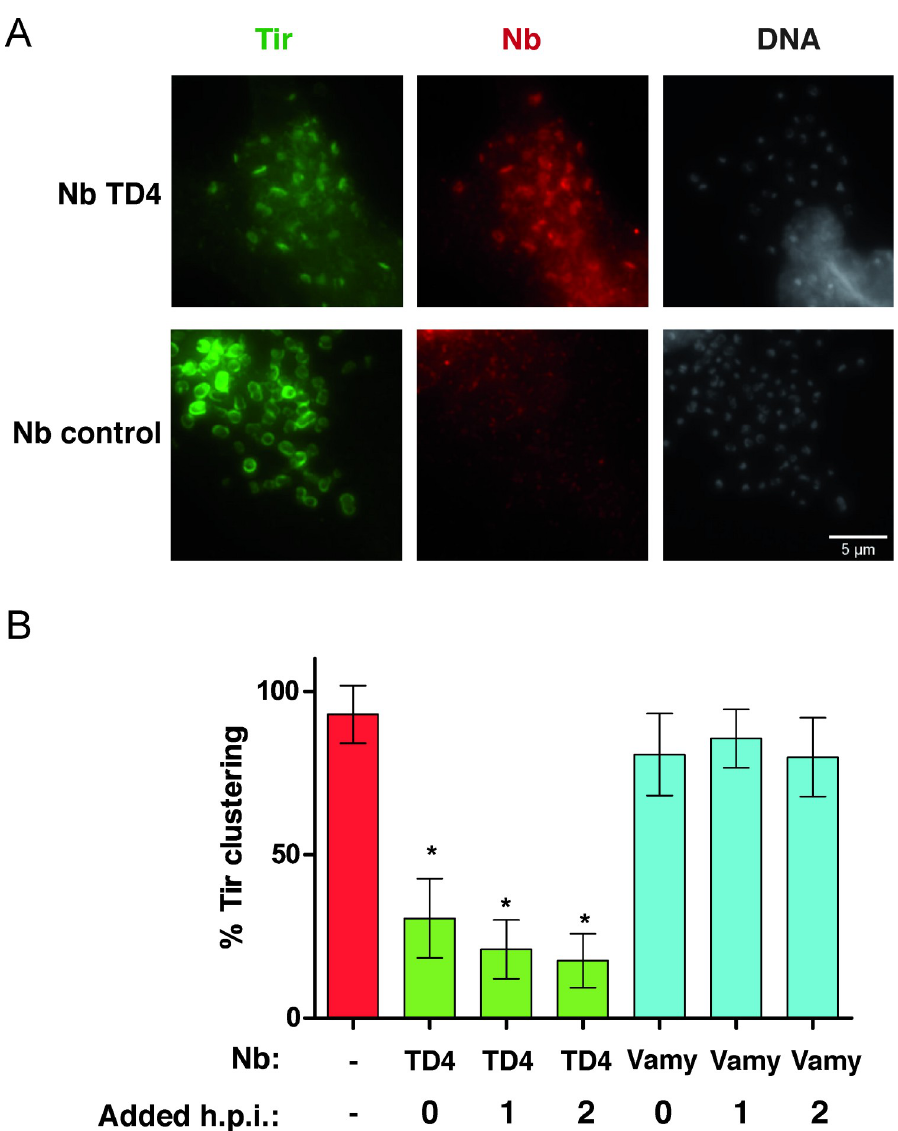
Fig 2. Visualization of TD4-Tir colocalization and effect of its addition after the beginning of the infection. A . Images of HeLa cells infected with EHEC for 3 h in the presence of 200 nM of TD4 or Nb control (Vamy). Cells were stained for Tir (green), HA-tag (red) and DAPI (gray). Bar = 5 μ m. B . Nbs were added at the beginning of the infection (0 h), 1 h or 2 h post infection (h.p.i.)., as indicated. The number of Tir clusters was put in relation with the total amount of bound bacteria per cell, for 50 cells randomly selected in different microscopic fields of the sample. � p < 0.05 versus EHEC control.